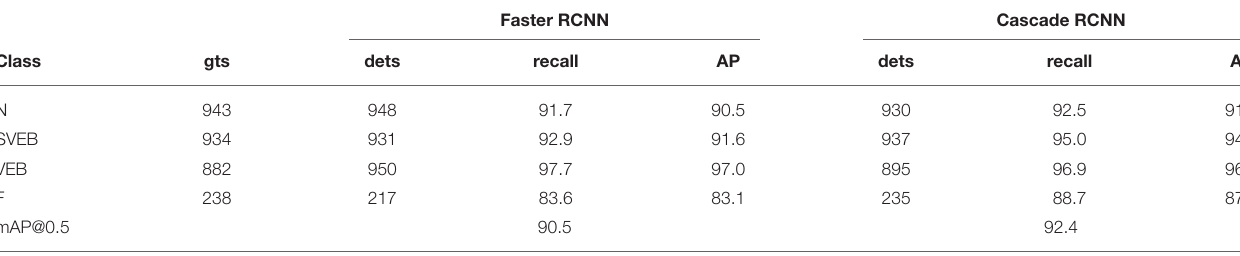
TABLE 5 | Comparison of detection performance between Faster RCNN and Cascade RCNN.